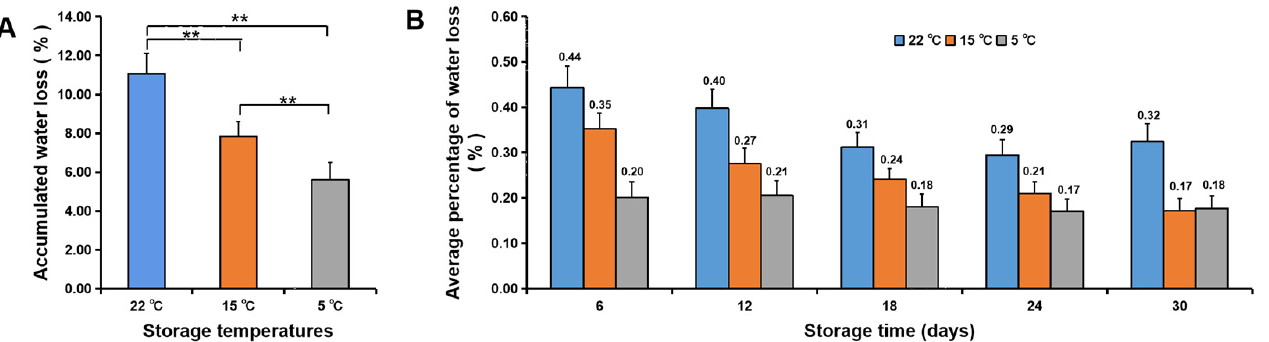
Figure 7. Water loss of navel orange fruit during storage at 5, 15 and 22 °C. ( A , B ), Accumulated water loss per fruit ( A ) and average water loss per fruit ( B ). The error bars represent the mean ± SD ( n = 20). **, p < 0.01.